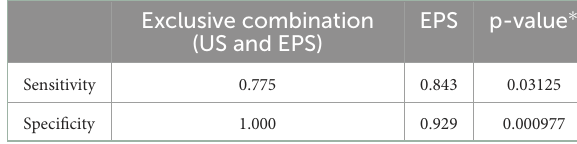
TABLE 6 Comparison of sensitivity and specificity between EPS and the exclusive combination of US and